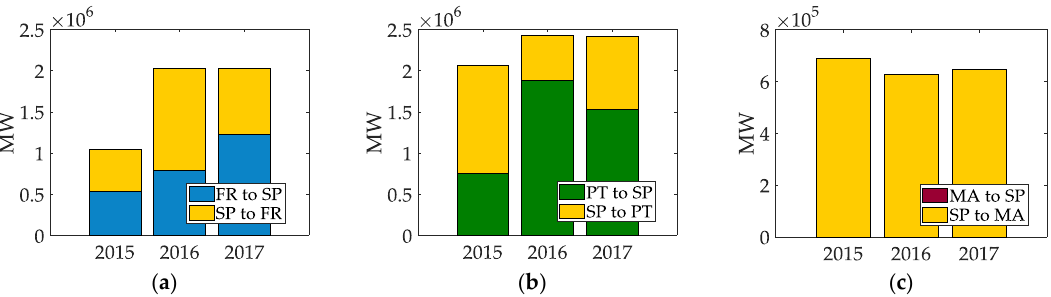
Figure 7. 2015–2017. Annual amount of renewables exchanged ( a ) between FR and SP; ( b ) between SP